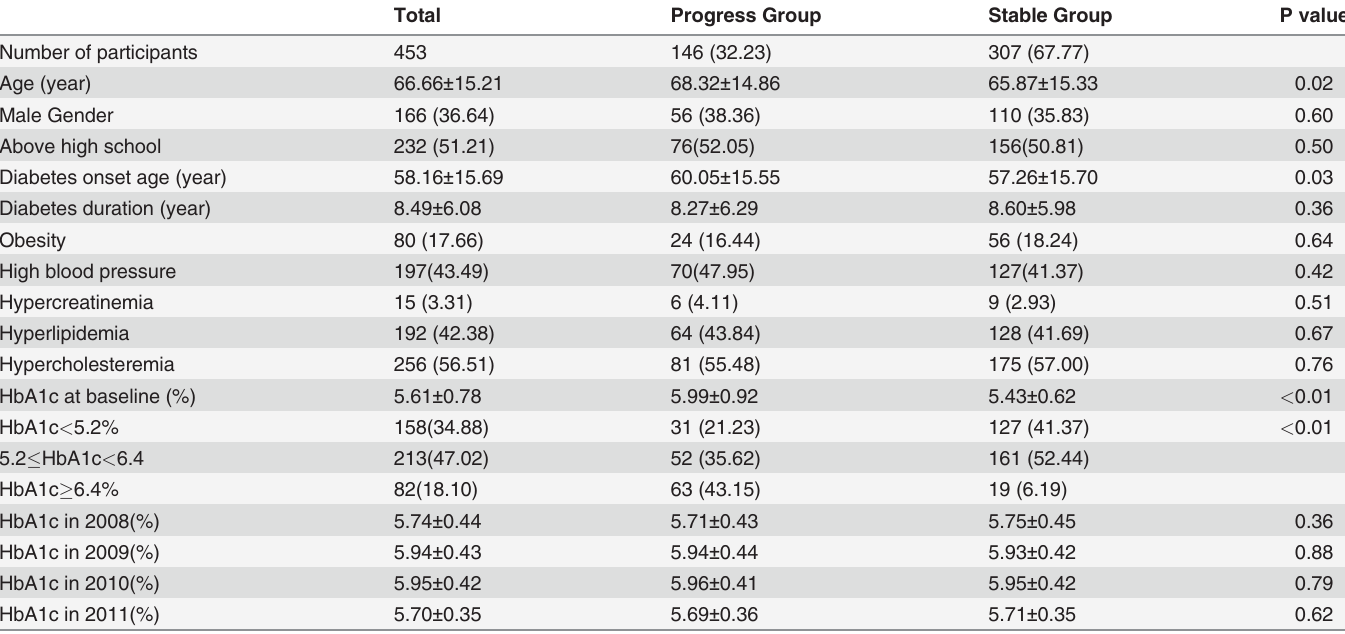
Table 1. Characteristics of the participants at the time of the baseline survey in 2007 and during the next 4-year follow-up period